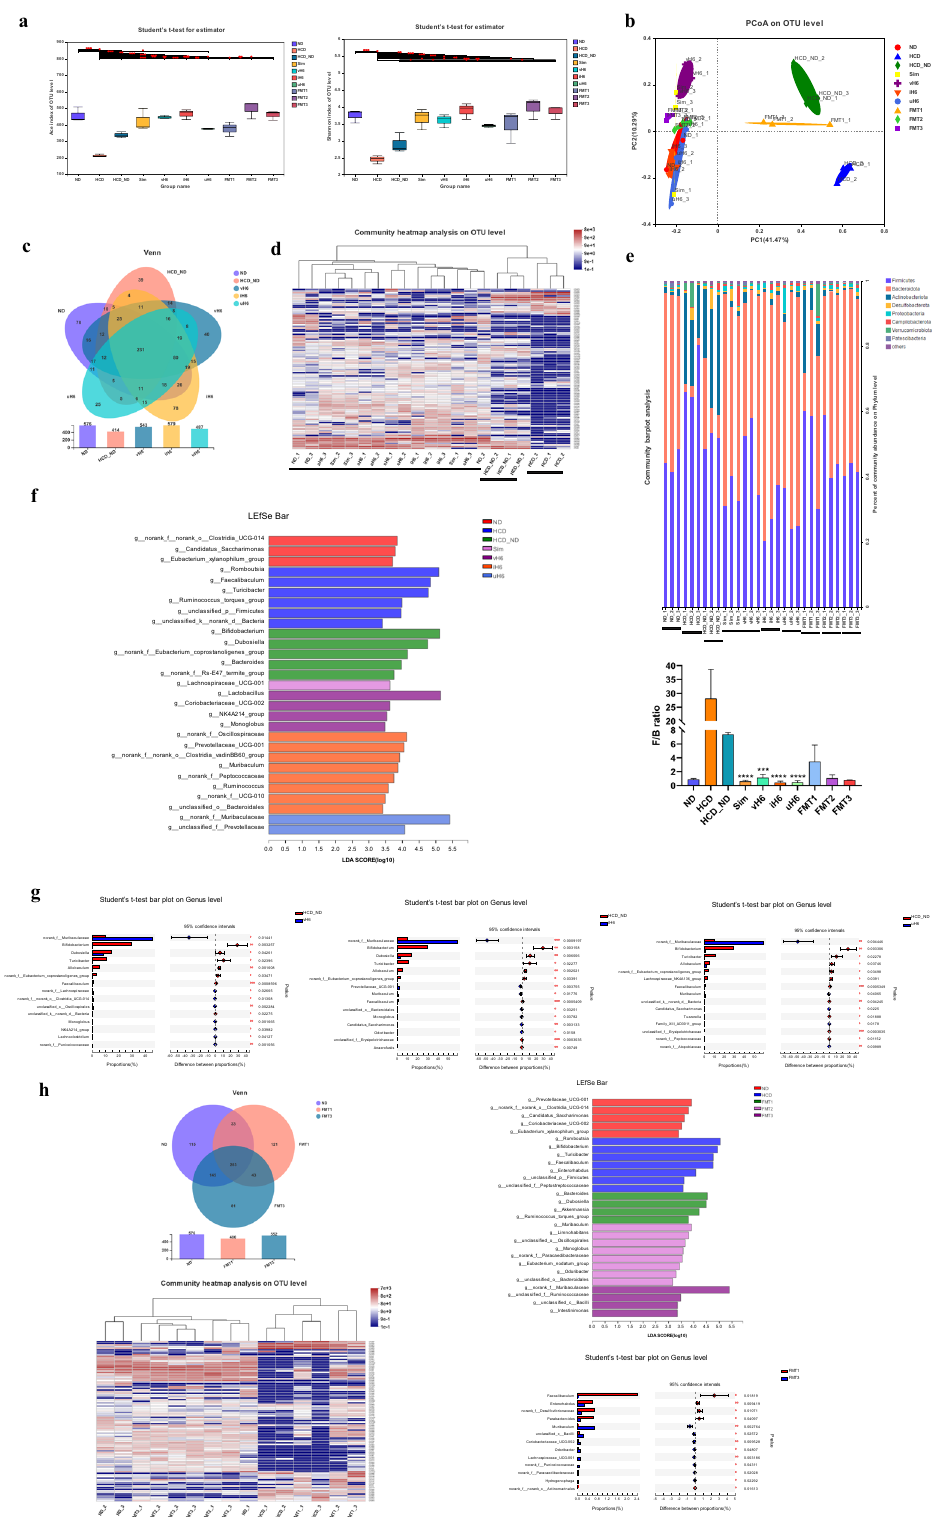
given iH6, and norank_f__Muribaculaceae when given uH6 (Fig. 4f). Student ’ s t test showed that in the HCD_ND group, the abundance of Faecalibaculum , Allobaculum and Turicibacter increased signi fi cantly compared to that of the v/i/uH6 treated group in which the abundance of